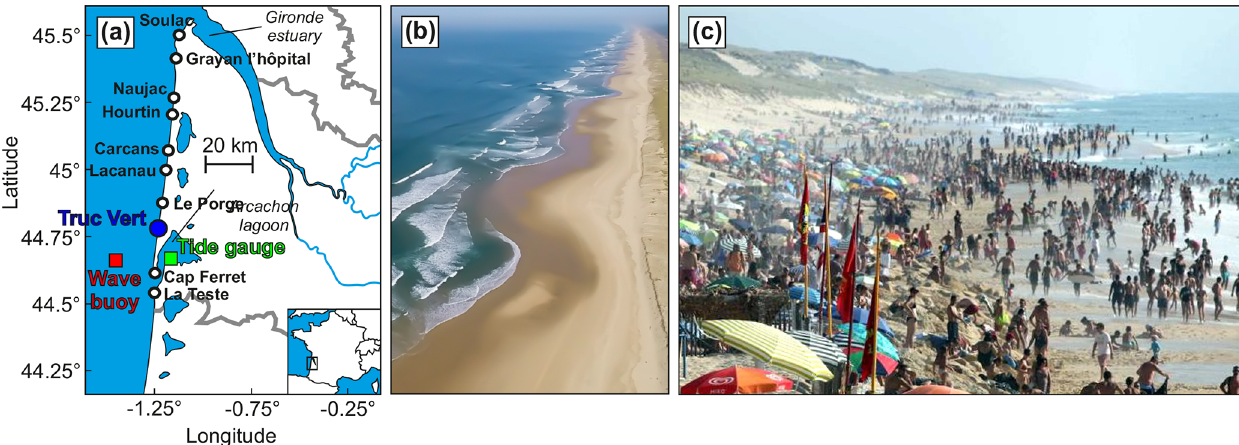
Figure 1. (a) Location map of the Gironde Coast, southwest France. Black circles indicate municipalities where injuries were reported. Locations of Truc Vert beach and wave and tide data used in this study are also indicated; (b) aerial photograph of Truc Vert beach at low